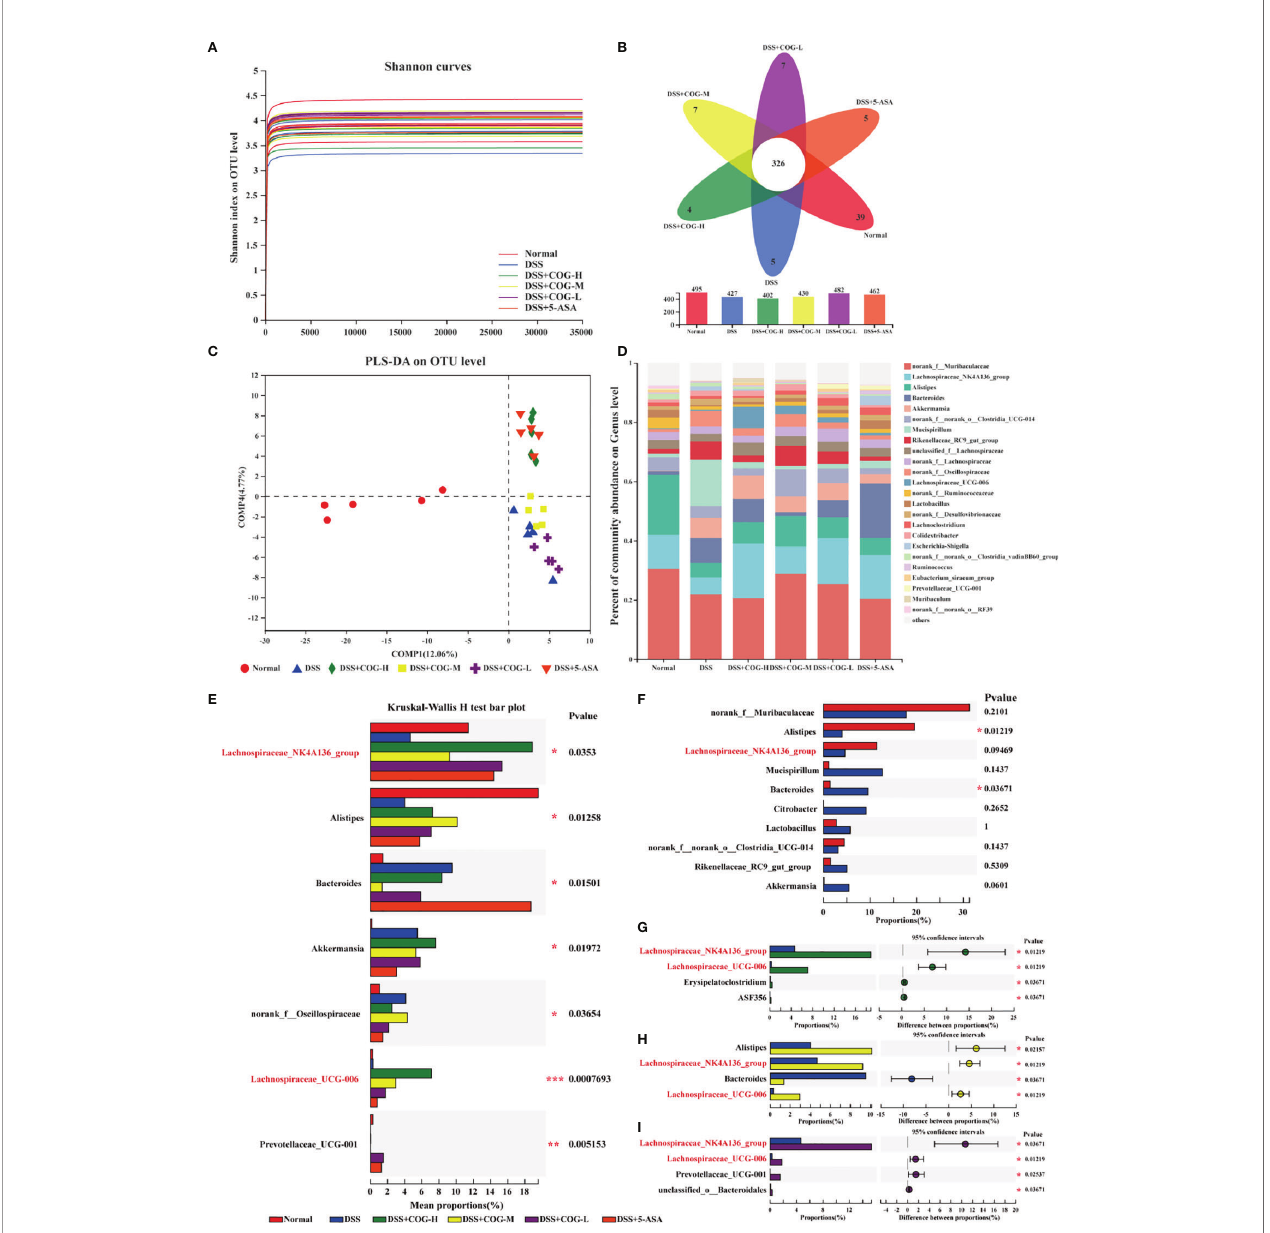
FIGURE 8 | COG improved the composition of gut fl ora in colitic mice. (A) Shannon index of operational taxonomic unit (OTU) level. (B) The Venn diagram depicts OTUs that differed in each group. (C) PLS-DA of OTU level of taxonomy of gut fl ora in mice. (D) The percentage of community abundance at the genus level. (E) Top 7 bacterial rankings of micro fl ora abundance at the genus level. (F) Comparisons between the normal group and the DSS group at the genus level. (G) Comparisons between the DSS group and the DSS+COG-H group at the genus level. (H) Comparisons between the DSS group and the DSS+COG-M group at the genus level. (I) Comparisons between the DSS group and the DSS+COG-L group at the genus level. n =